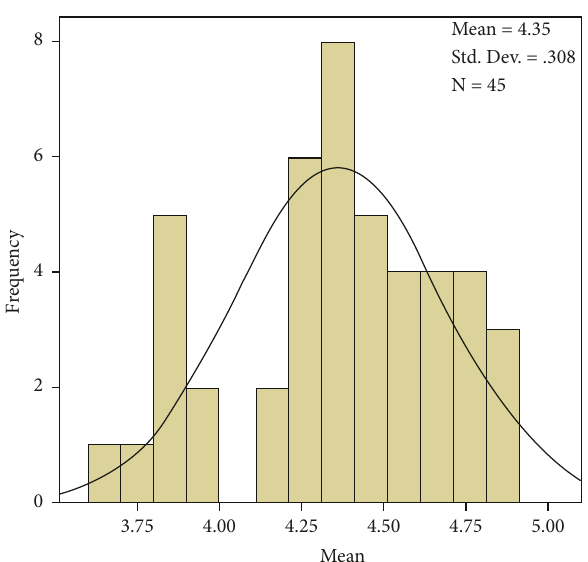
Figure 5: Histogram diagram of average expert opinions about system output.